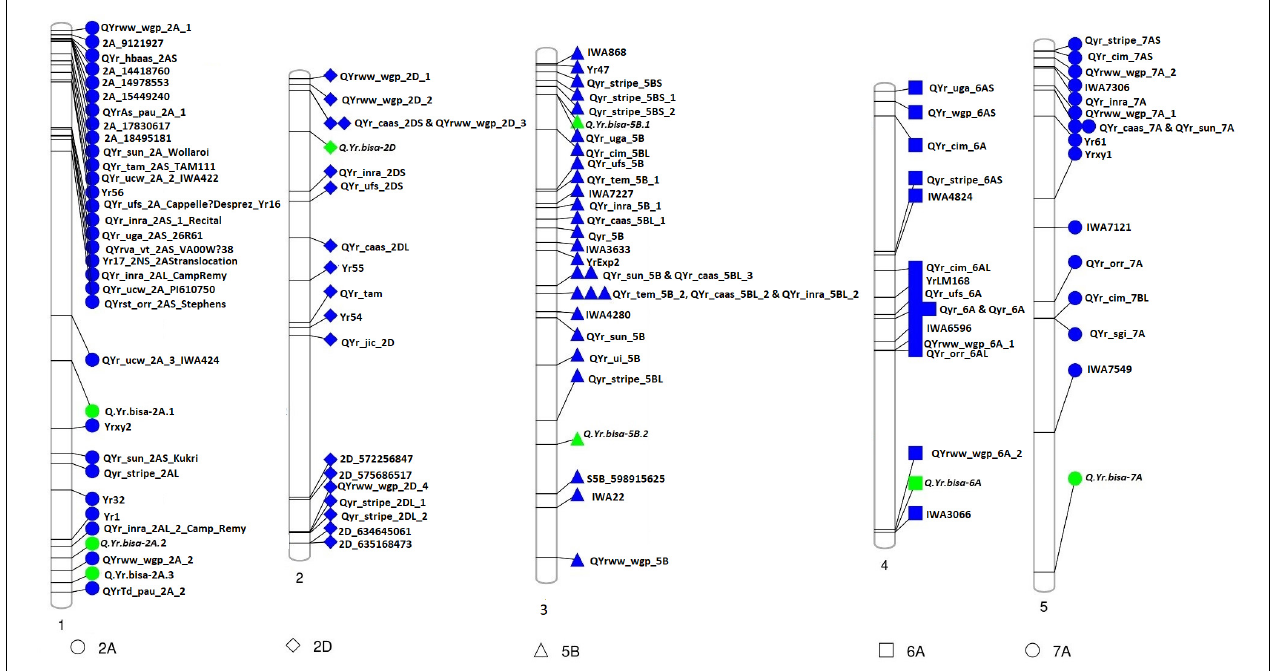
FIGURE 4 | Physical map of candidate QTLs for stripe rust resistance (represented in green) indicating physical positions on the respective chromosomes along with genes/QTLs identified in previous studies (represented in blue). QTLs, quantitative trait